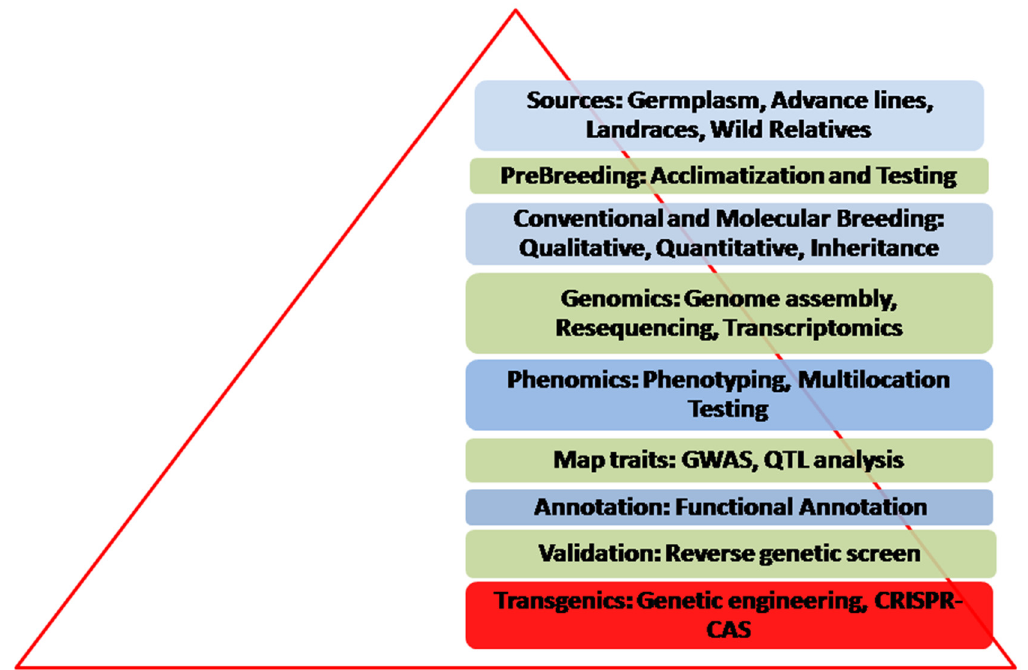
Figure 2. Stages and best approaches for consideration in vegetable legumes improvement.